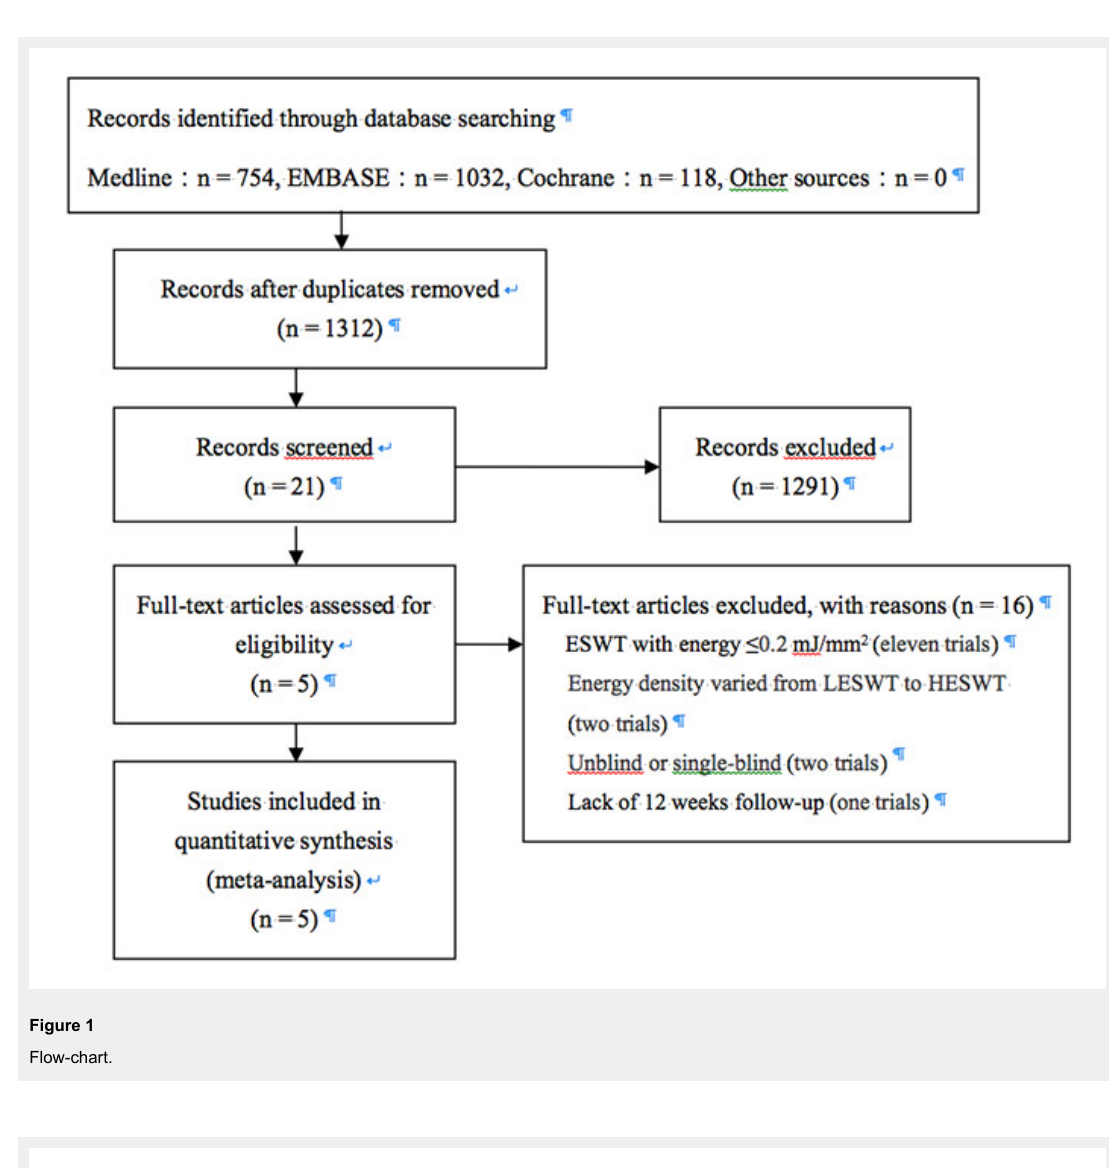
Figure 1 Flow-chart.